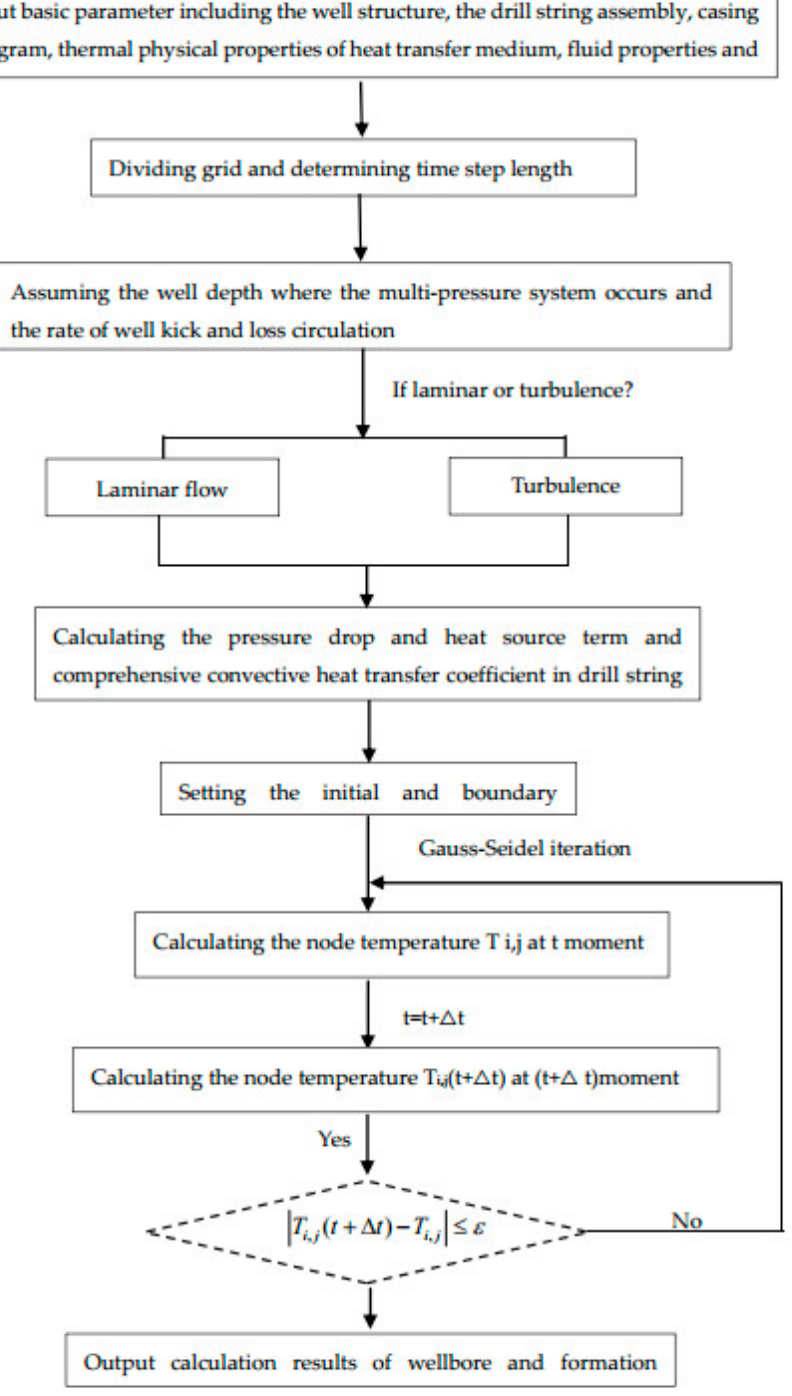
Figure A2. Flowchart of wellbore and formation temperature calculation.